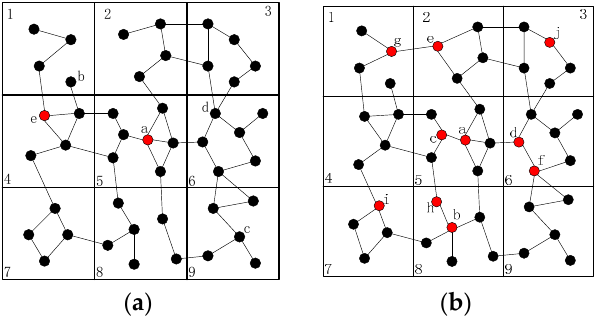
Figure 5. ( a ) Inner-grid node failures; and ( b ) inter-grid node failures.